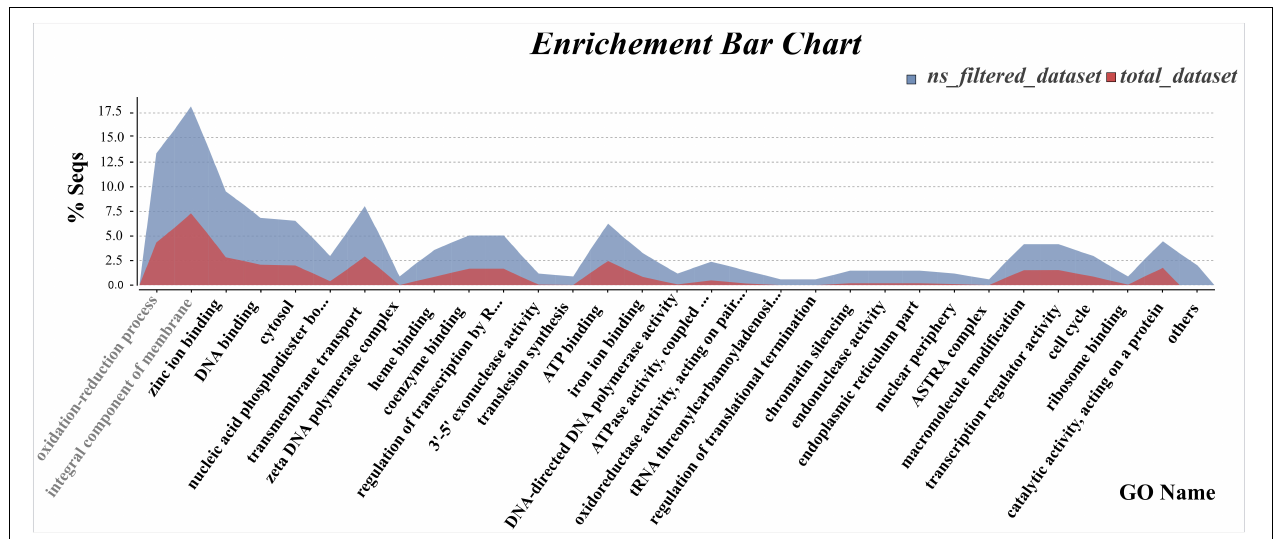
FIGURE 5 | Enrichment of gene functional categories among total_dataset and ns_filtered_dataset . Curve chart comparing the proportion of genes per GO term between ns_filtered_dataset and total_dataset with a statistically significance of FDR < 0.05, according to the Fisher’s exact test. The two most distinct GO term categories are evidenced in light